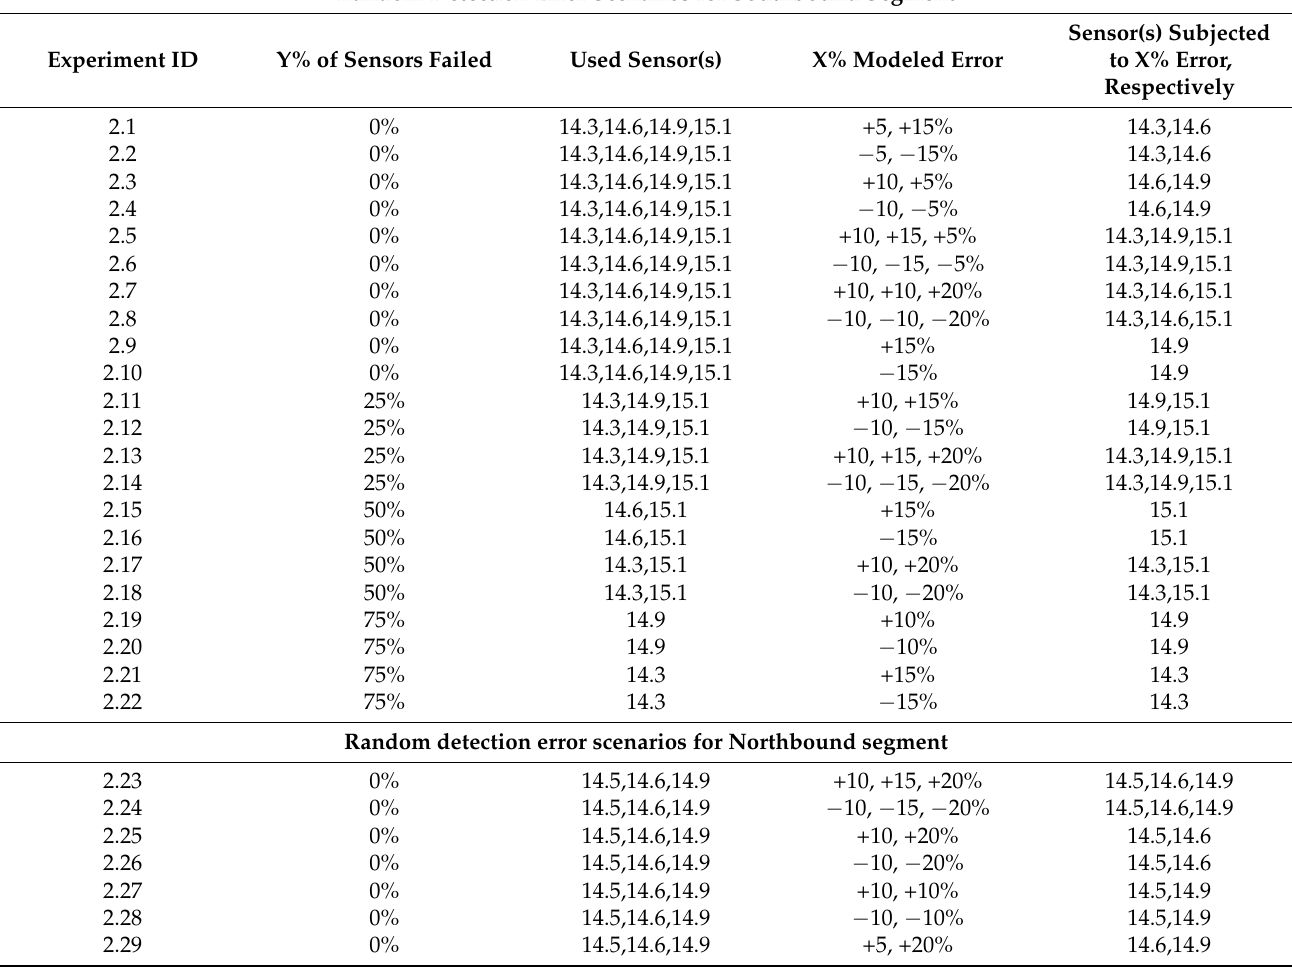
Table 3. Experiments of random detection error in Scenario